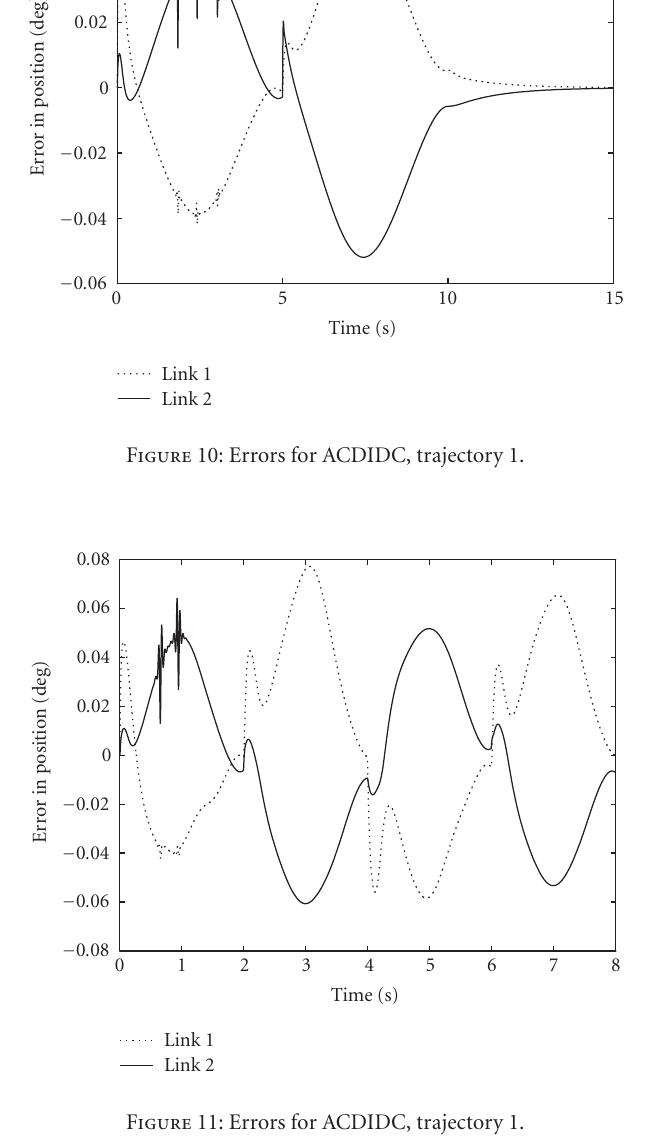
Figure 11: Errors for ACDIDC, trajectory 1.